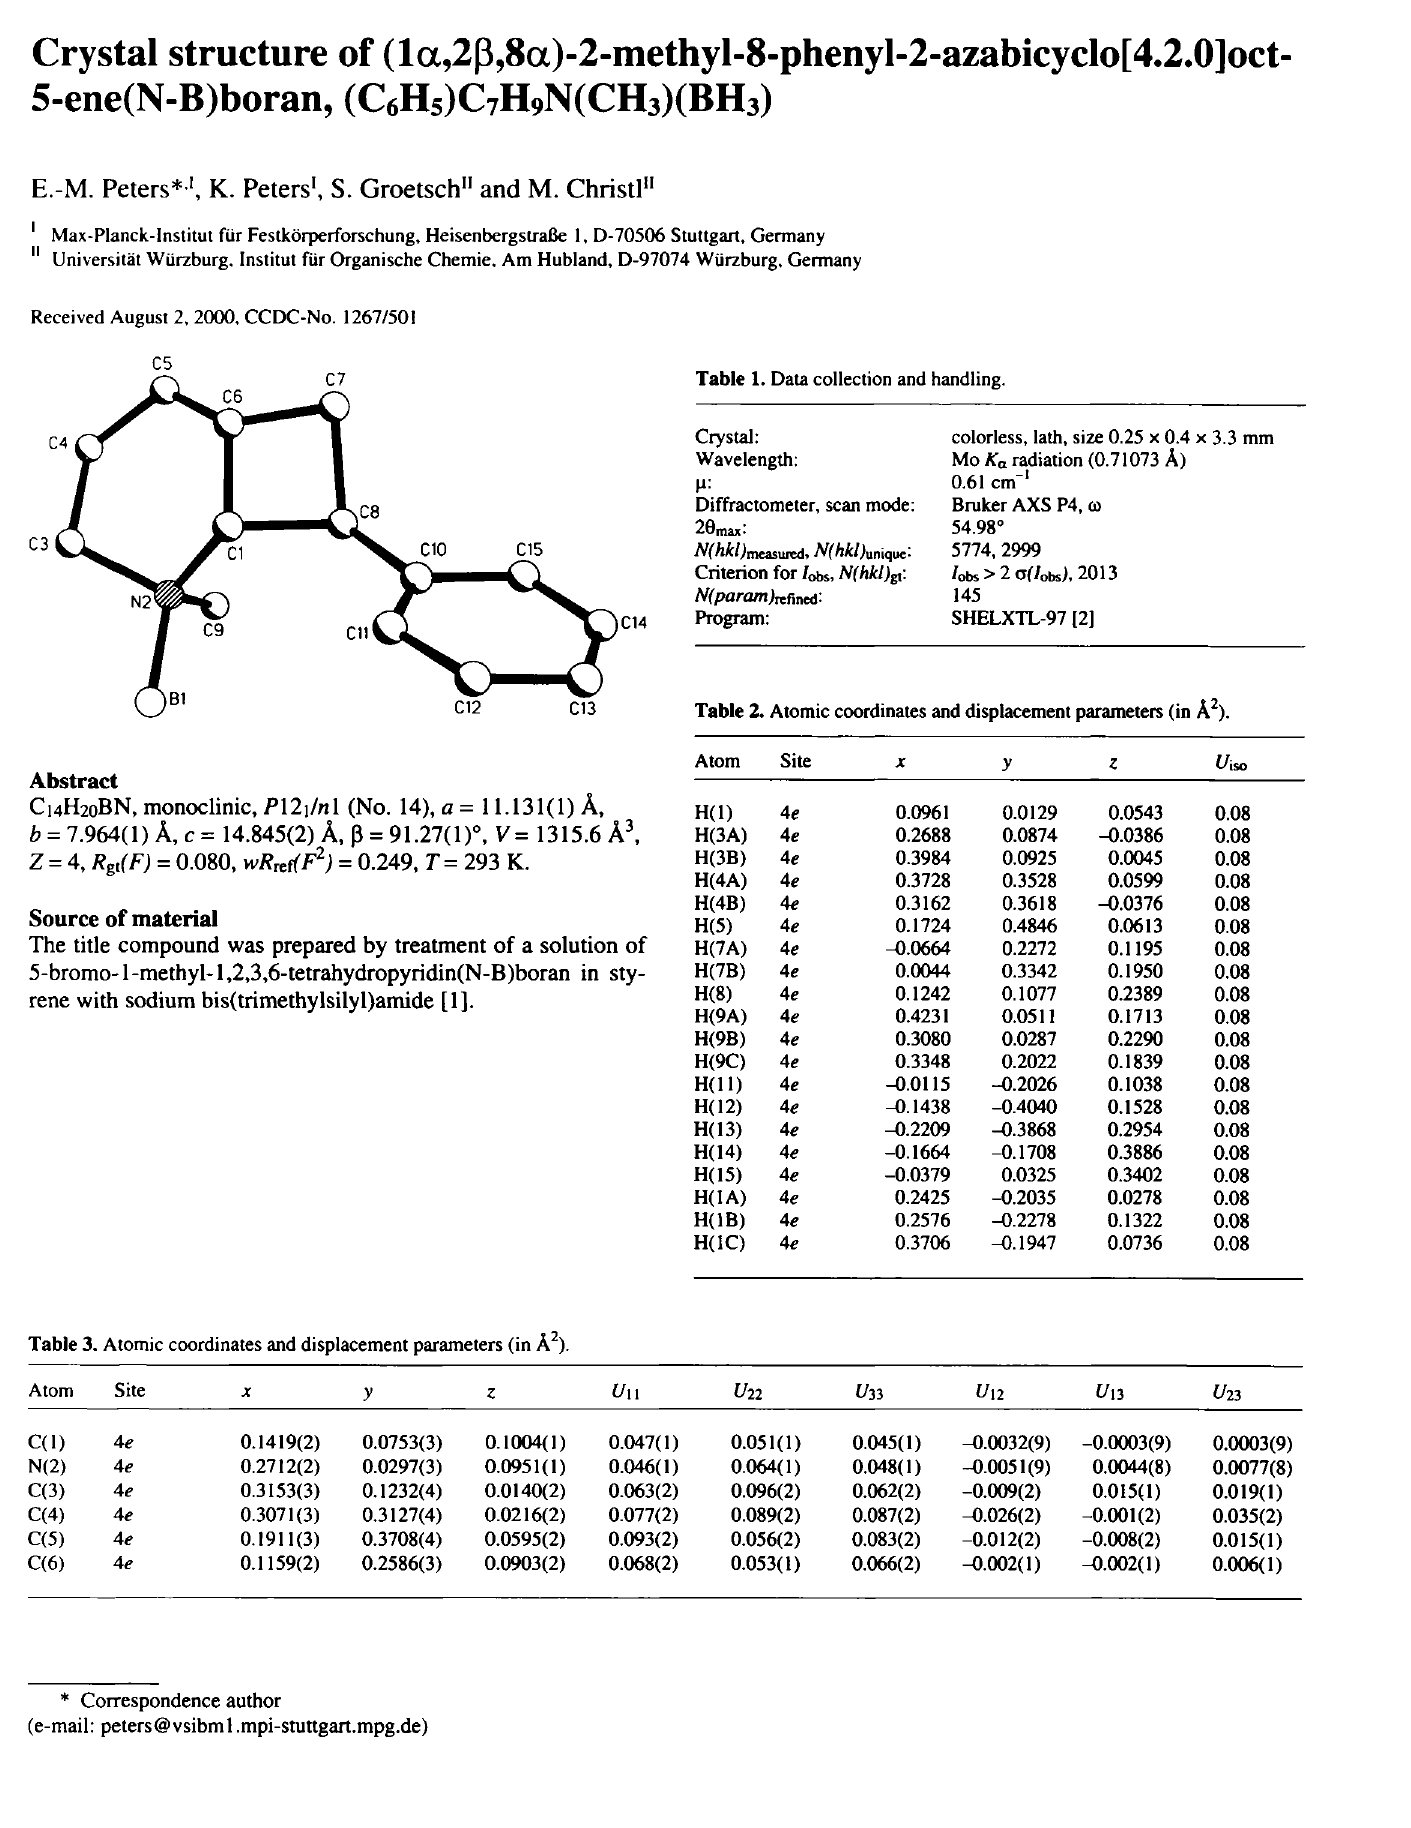
Table 3. Atomic coordinates and displacement parameters (in A 2